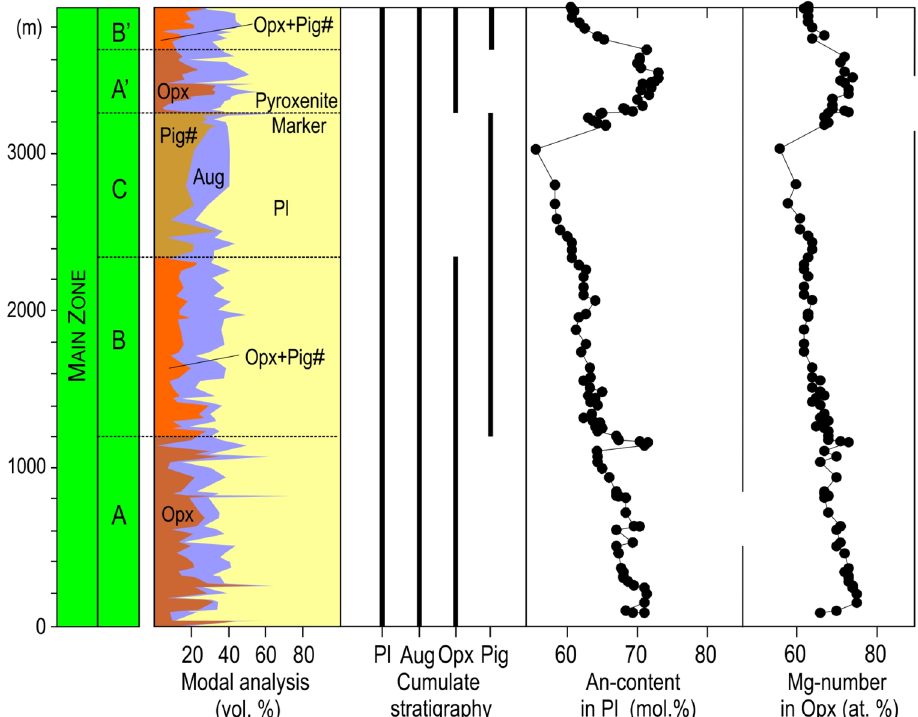
Figure 6. Modal abundances, cumulate stratigraphy and compositional variations of minerals through the Main Zone in the Tonteldoos area of the southeastern part of the Bushveld Complex. The section is approximately along the transect line CD in Figs. 1 and 2. The lower stratigraphy is characterized by a systematic crystallization sequence Opx + Aug + Pl (A), Opx + Aug + Pig + Pl (B), and Aug + Pig + Pl (C). The uppermost stratigraphy is marked by re-appearance of cumulus Opx at the Pyroxenite Marker so that the crystallization sequence Opx + Aug + Pl (A ′ ) and Opx + Aug + Pig + Pl (B ′ ) is repeated. The lower stratigraphy shows systematic evolutionary trends in composition of plagioclase (decrease in An-content, 100Ca/(Ca + Na)) and orthopyroxene (decrease in Mg-number, 100 Mg/(Mg + Fe)). The transition to the Pyroxenite Marker is characterized by a gradual compositional reversal towards higher An-content of plagioclase and Mg-number of orthopyroxene. Mg-number in subzone C is for orthopyroxene that is produced by inversion of primary pigeonite. All compositional data in (a–e) are from Gruenewaldt 41 and are summarized in Supplementary Data Table 1. Pl, plagioclase; Opx, orthopyroxene; Aug, augite; Pig#, inverted pigeonite. The figure was prepared by Sofya Chistyakova using CorelDRAW (version